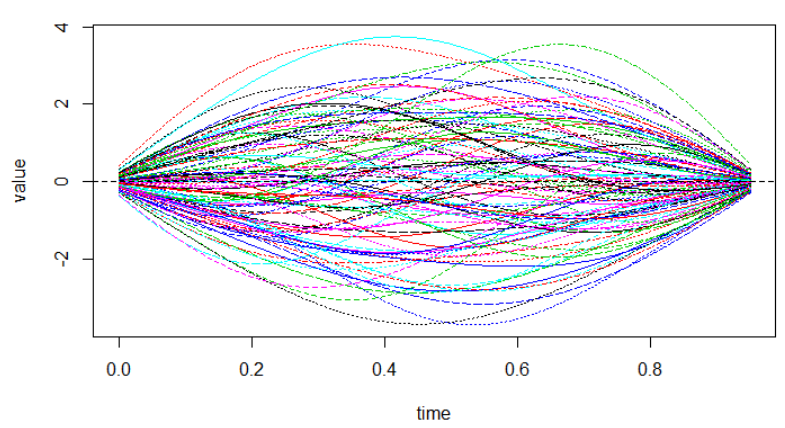
Figure 3. One trajectory.